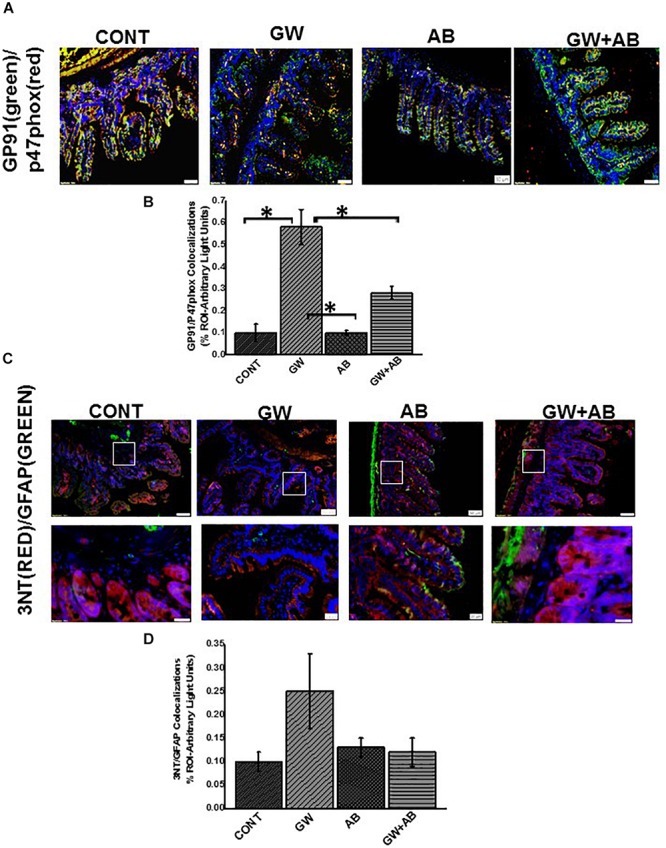
NADPH oxidase 2 and peroxynitrite mediated oxidative stress in vivo. (A) NOX-2 activation in small intestine assessed by immunofluorescence microscopy (n = 9) (at total magnification 200X and scale 50 μm). Activation of NOX 2 was studied through observing colocalizations between GP91phox (labeled with green fluorescent antibody) and P47 phox (labeled with red fluorescent antibody) subunits of the NADPH 2 oxidase complex resulting in a yellow region. Colocalizations were determined in small intestine tissues of CONT, GW, AB, and GW + AB chemical exposed mice. (B) Graphical representation of morphometric analysis of colocalization events of GP91phox and P47phox in the region of interest. (C) Immunoreactivity of 3-nitrotyrosine (3NT) in EGC assessed through observing colocalizations between GFAP (labeled with green fluorescent antibody) and 3NT phox (labeled with red fluorescent antibody) at top panel magnification 200X, scale 50 μm and bottom panel magnification 600X and scale 20 μm) Colocalizations were determined in small intestine tissues of CONT, GW, AB, and GW + AB chemical exposed mice. (D) Graphical representation of morphometric analysis of colocalization events of GFAP (green) and 3NT (red).